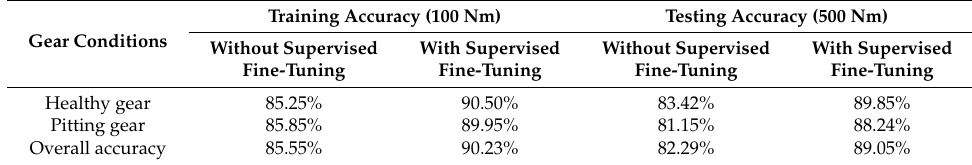
Table 8. Detection results of DNN at mixed rotating speeds (trained with light loading samples and tested with heavy loading samples).